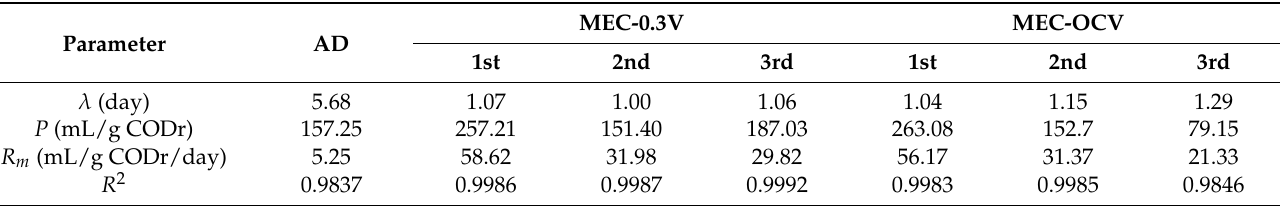
Table 3. Modified Gompertz model